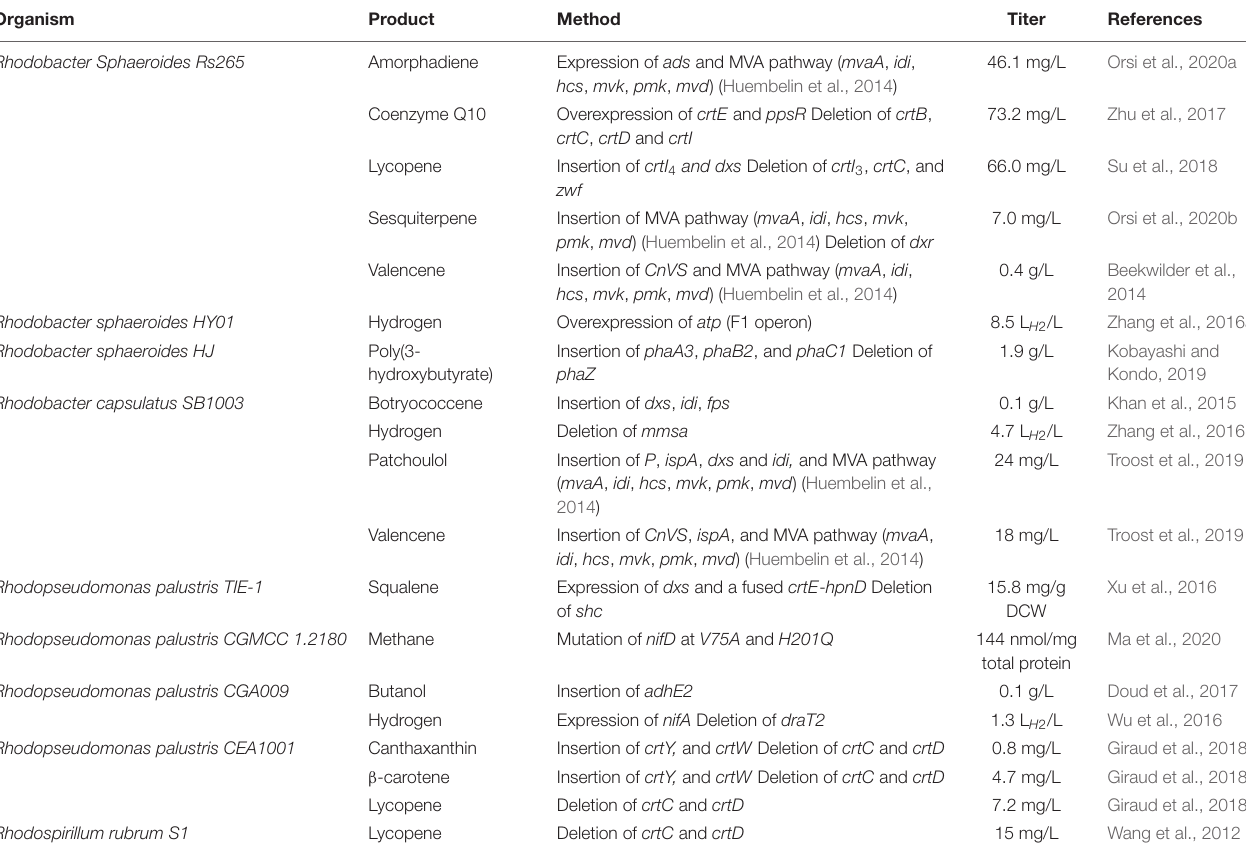
TABLE 2 | Purple non-sulfur bacteria as cell factories: the production of heterologous products and overexpression of native products via genetic modification and the production titers thereof.